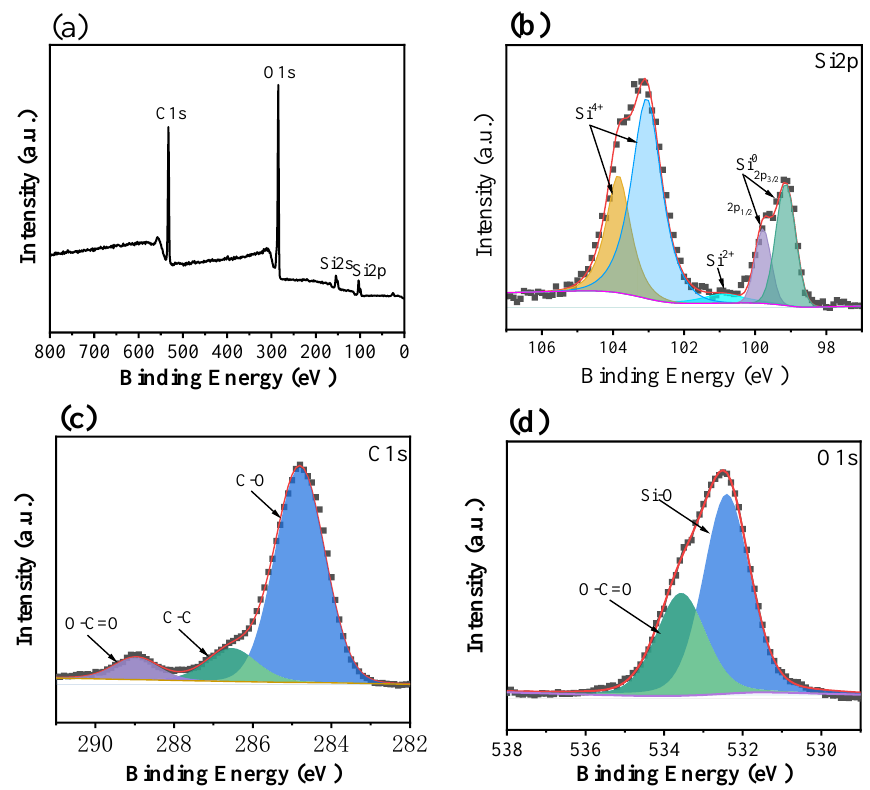
Figure 3. ( a ) XPS spectra, ( b ) Si2p, ( c ) C1s, and ( d ) O1s of Si/CNT@C